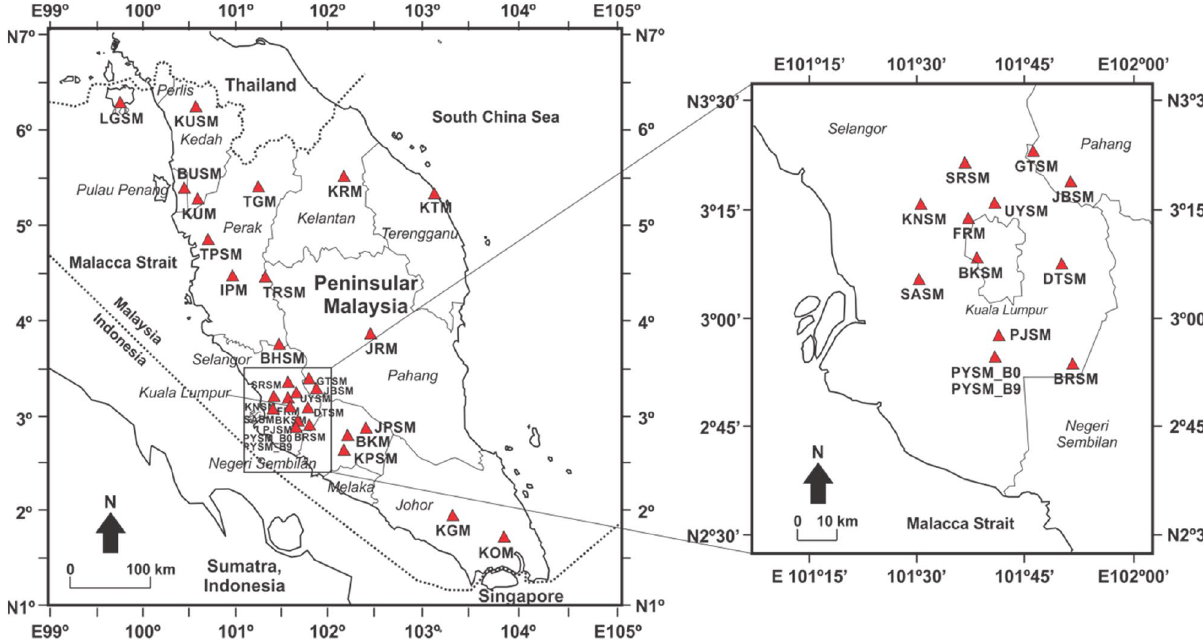
Fig. 2 Location map of all permanent, local seismological stations used in this study to monitor earthquakes in Peninsular Malaysia during 2007–2016. Triangles indicate locations of seismological stations operated by MMD (MetMalaysia). Note: Created with